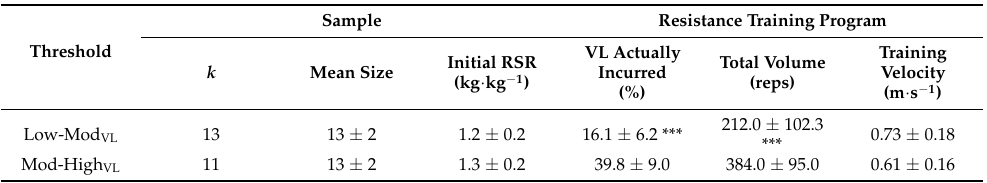
Table 3. Characteristics of the sample and the resistance training (RT) programs conducted by Low-Mod VL and Mod-High VL thresholds. Sample Threshold